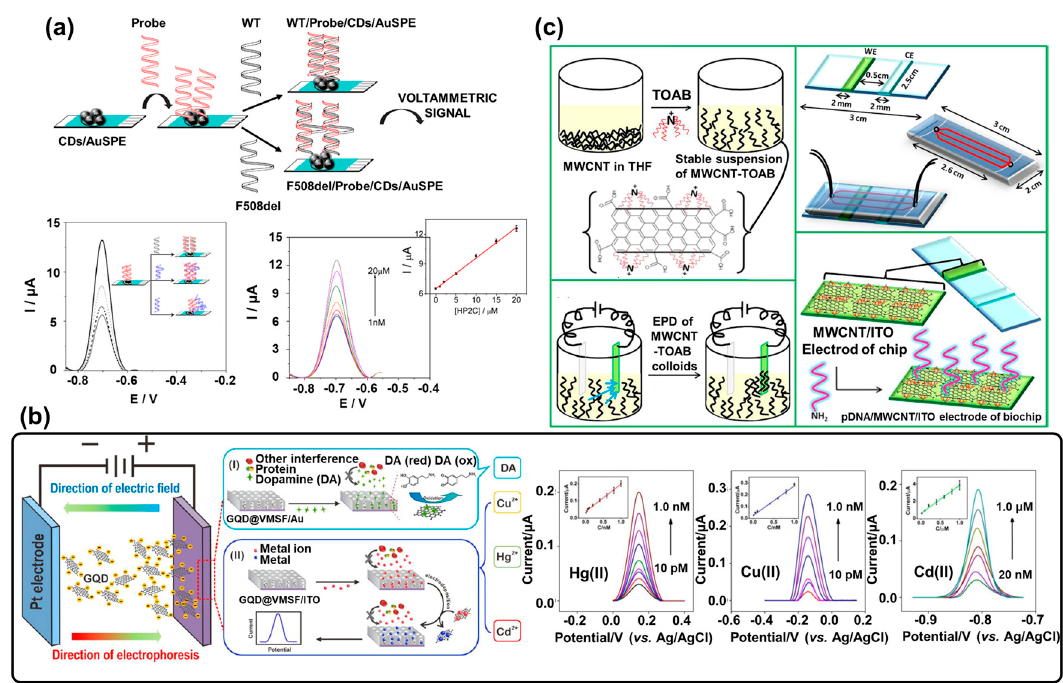
Figure 3. Biosensors based on carbon nanomaterials. ( a ) Schematic images of a DNA biosensor composed of carbon nanodots (CNDs) on a screen-printed disposable electrode to detect gene mutations, and differential pulse voltammetry (DPV) analysis of electrochemical detection performance (reproduced with permission from Reference [62], published by Elsevier, 2018). ( b ) An ultrasensitive electrochemical biosensor based on surface-modified graphene quantum dots (GQDs) to detect metal ions and small molecules, and DPV analysis of Hg(II), Cu(II), and Cd(II) detection (reproduced with permission from Reference [63], published by American Chemical Society, 2018). ( c ) A schematic of an electrochemical microfluidic DNA biosensor based on multiwalled carbon nanotubes (MWCNTs) (reproduced with permission from Reference [64], published by Elsevier, 2018).